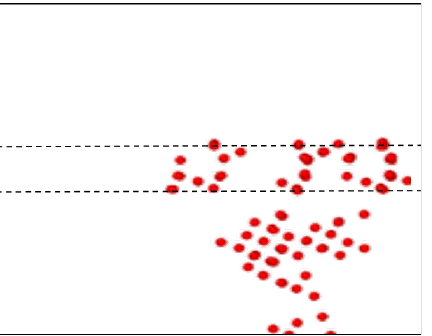
Figure 3. Time evolution of the ratio of migrating Fe atoms to the total Fe atoms in the GB and intragranular regions ( a ) for Σ 3 GB, ( b ) for Σ 3 GB with a vacancy, and ( c ) for Σ 5 GB with a vacancy: For each GB case, three temperatures, i.e., 600 K, 700 K, and 800 K, were used.